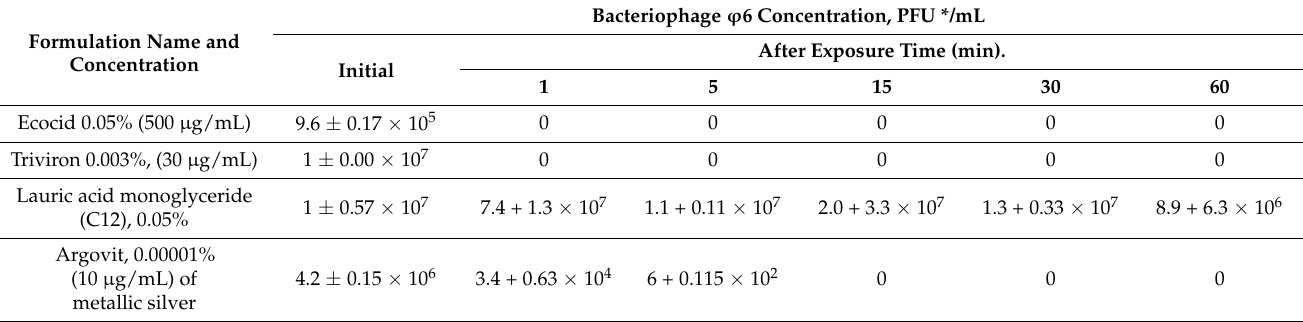
Table 2. Change in the concentration of bacteriophage ϕ 6 after incubation with virucidal drugs. Formulation Name and